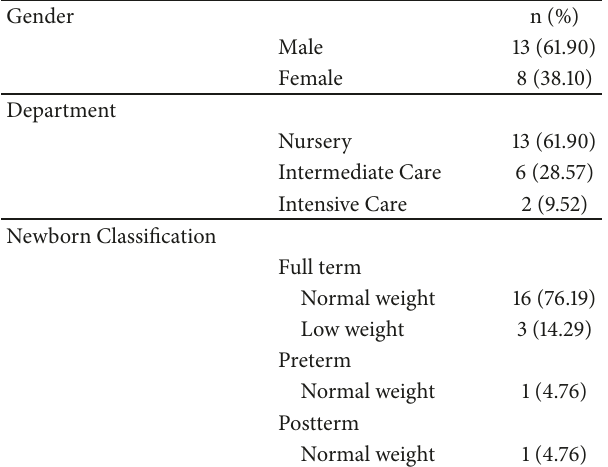
Table 3: BiliCare (cid:2) intra-apparatus